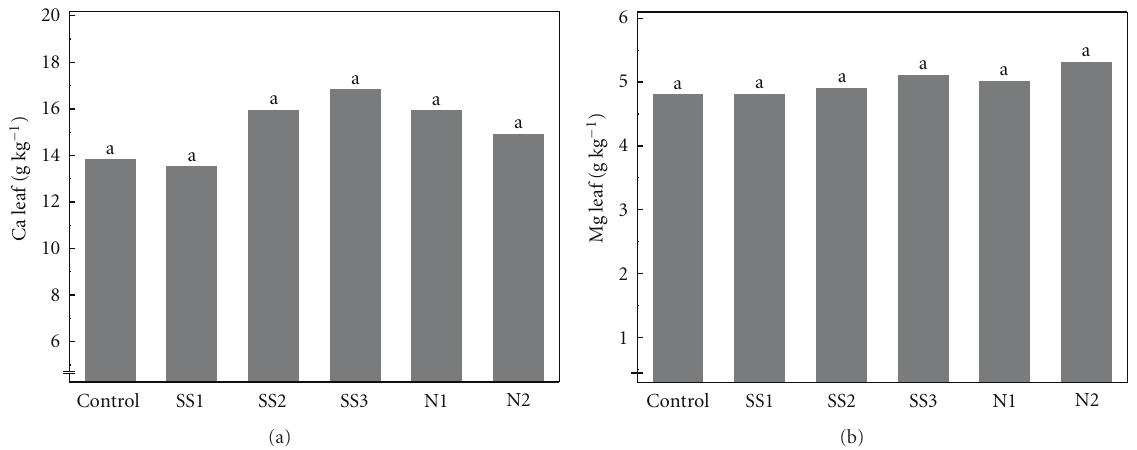
Figure 4: Calcium (Ca) (a) and magnesium (Mg) (b) in banana index leaves from plots treated with biosolids (SS) and mineral N fertilizer (N). Columns followed by the same letters do not di ff er by the Student’s t -test ( P > .